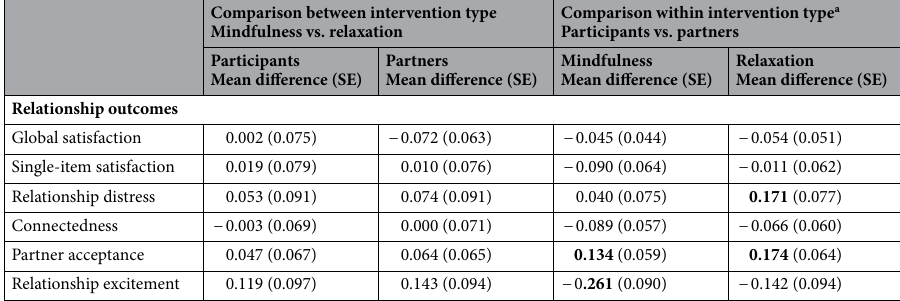
Table 1. Mean comparisons of pre-intervention outcomes for participants and partners for the two intervention groups. Bold print indicates significant effects (p < 0.05); Participants mindfulness intervention N = 304, Participants relaxation intervention N = 254. a Paired